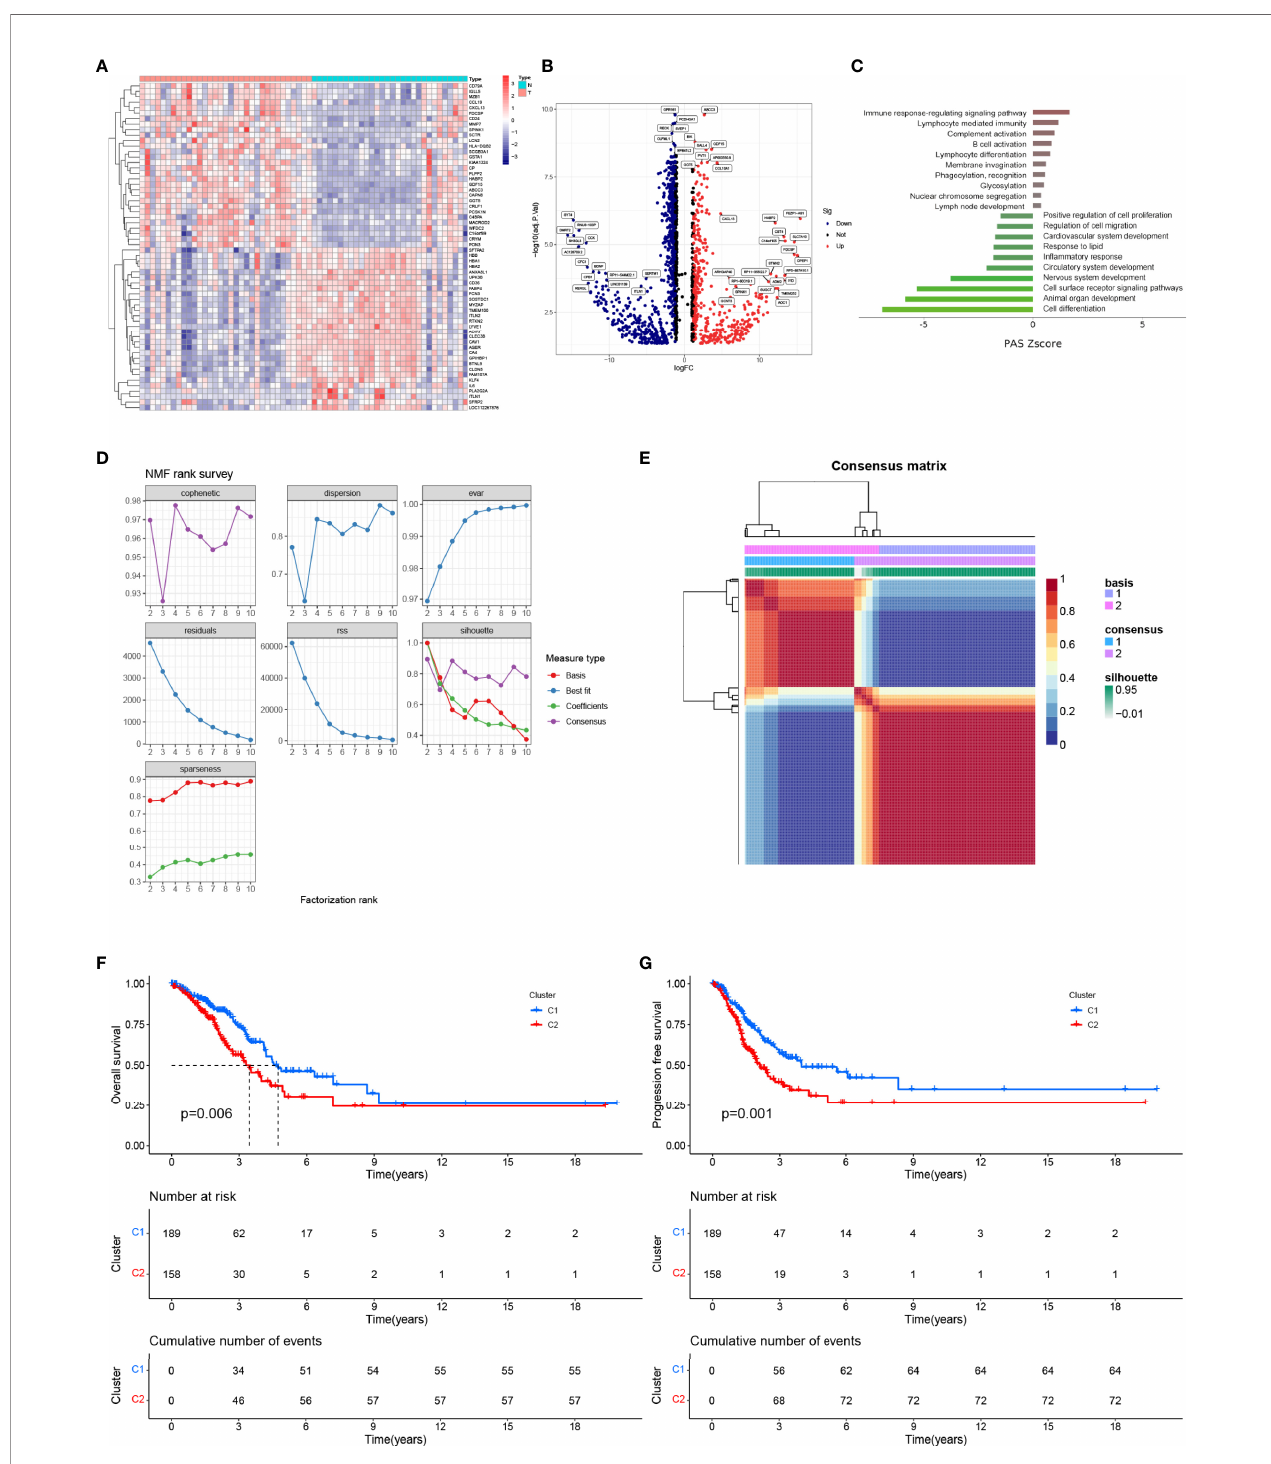
FIGURE 1 | Identi fi cation of DEGs between pGGO and adjacent normal tissue and NMF clustering. (A) Heatmap of the DEGs (|log FC|> 1, FDR P < 0.05); (B) Volcano map of the DEGs (|log FC|> 1, FDR P < 0.05); (C) KEGG pathway enrichment analysis of the DEGs; (D, E) NMF clustering of patients with Stage I – II LUAD in the TCGA-LUAD cohort ( D shows the NMF rank survey and E shows a heatmap of the consensus matrix; the best cluster number was chosen as the coexistence correlation coef fi cient K value = 2); (F, G) Kaplan – Meier survival curves for the NMF subgroups ( F shows OS and G shows PFS). DEGs, differentially expressed genes; GGO, ground-glass opacity; KEGG: Kyoto Encyclopedia of Genes and Genomes; NMF, non-negative matrix factorization; LUAD, lung adenocarcinoma; PFS, progression-free survival; OS, overall